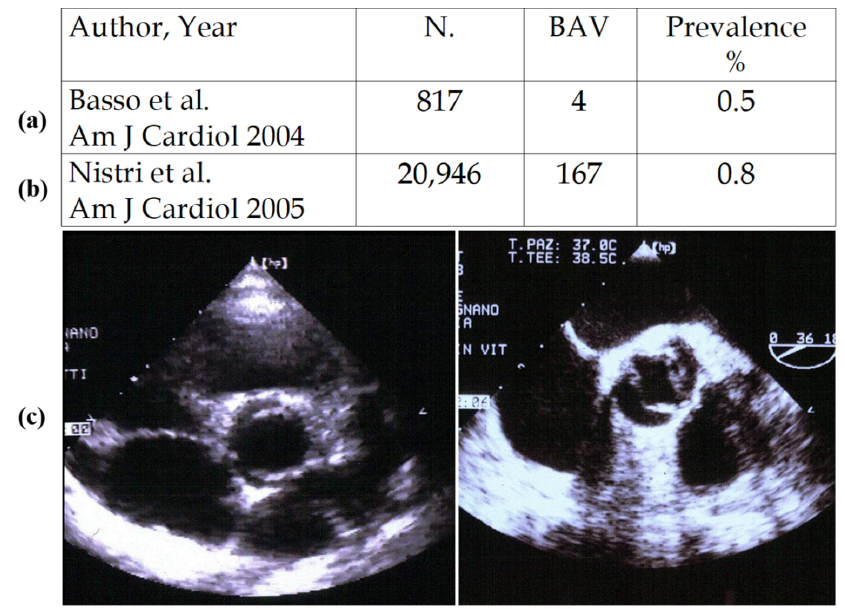
Figure 3. Prevalence of BAV in children ( a ) and conscript soldiers ( b , c ) by echo. Adapted from [7,8], with permission.